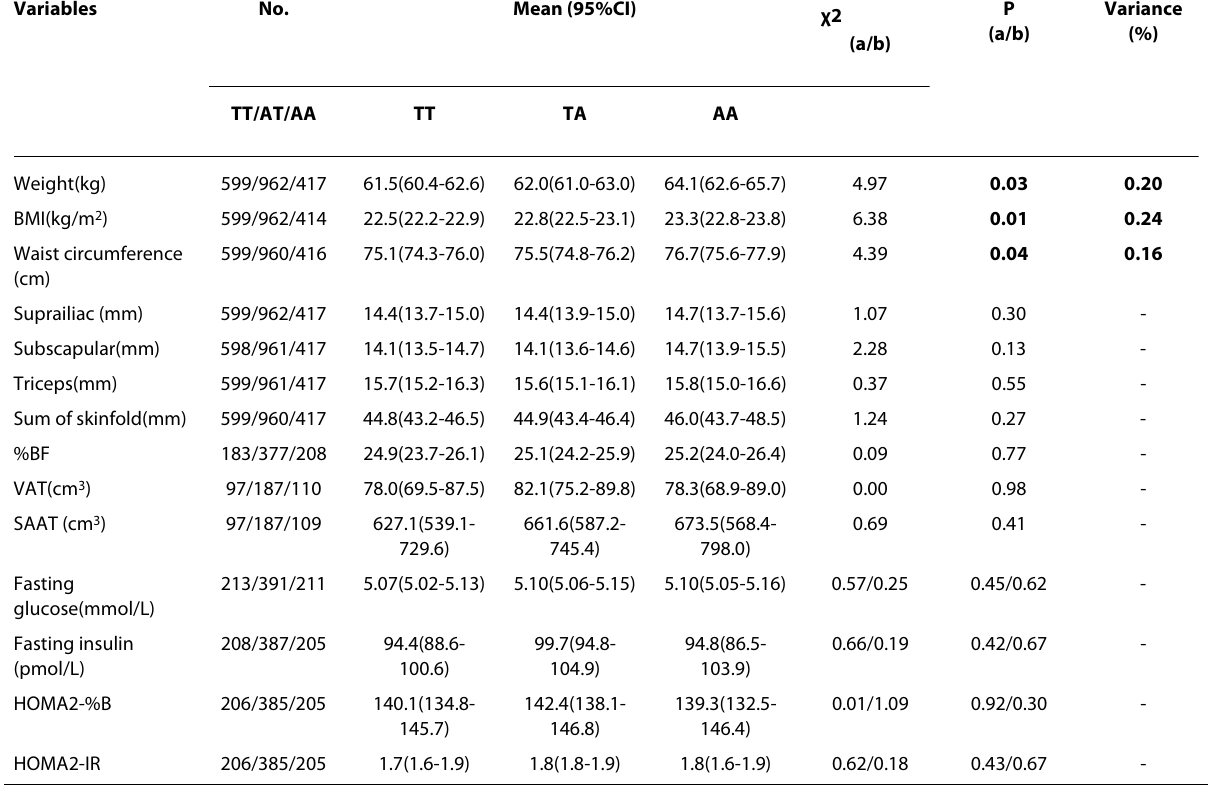
Table 3: Association between rs9939609 and adiposity-related phenotypes Variables